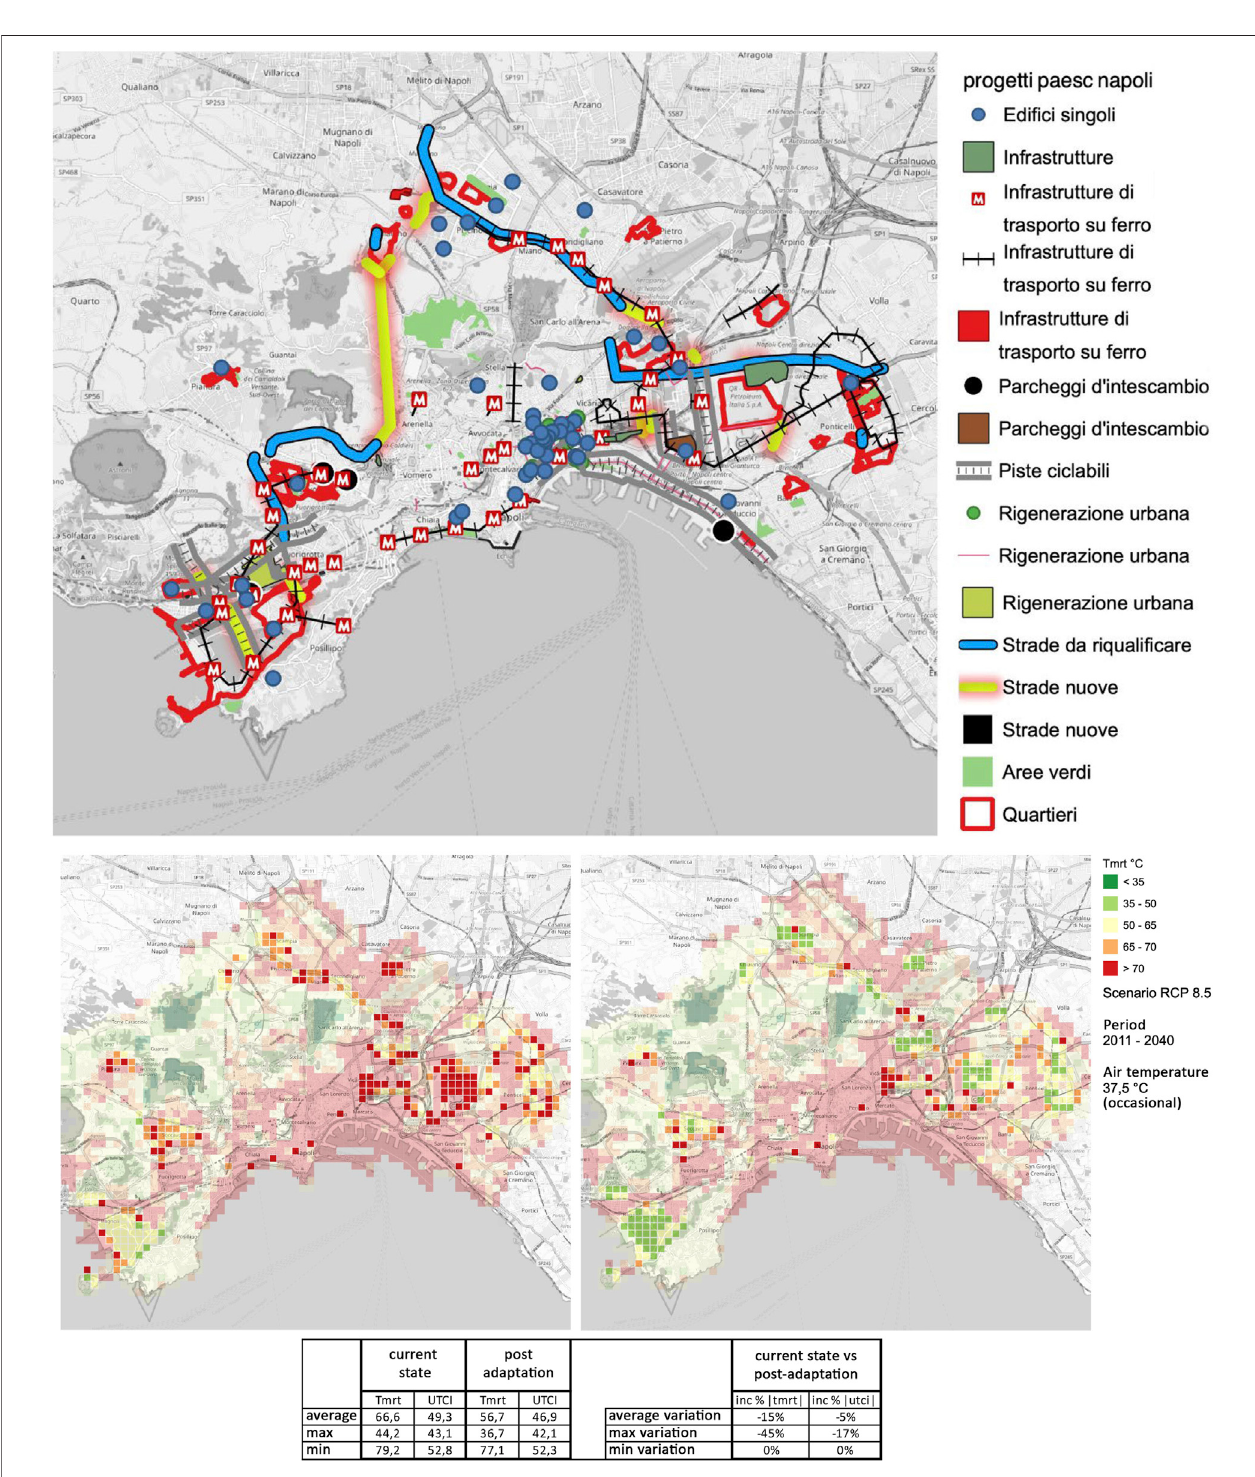
FIGURE 10 | Ongoing and planned urban regeneration projects in Naples (top) and potential bene fi ts in terms of climate adaptation (bottom) .